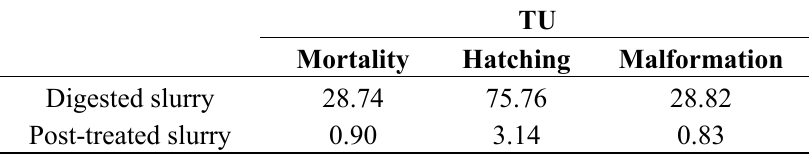
Table 6. TUs of digested and post-treated slurry to mortality, hatching and malformation rate of zebrafish embryo.